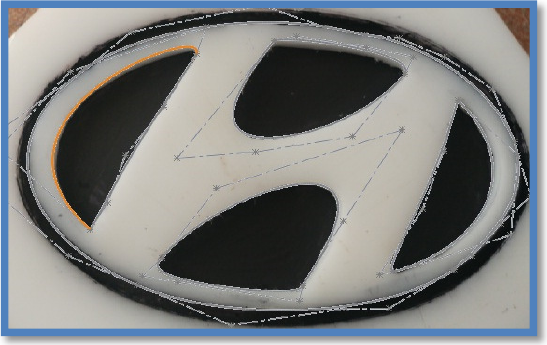
Fig. 8. Final shape of the proposed case study.